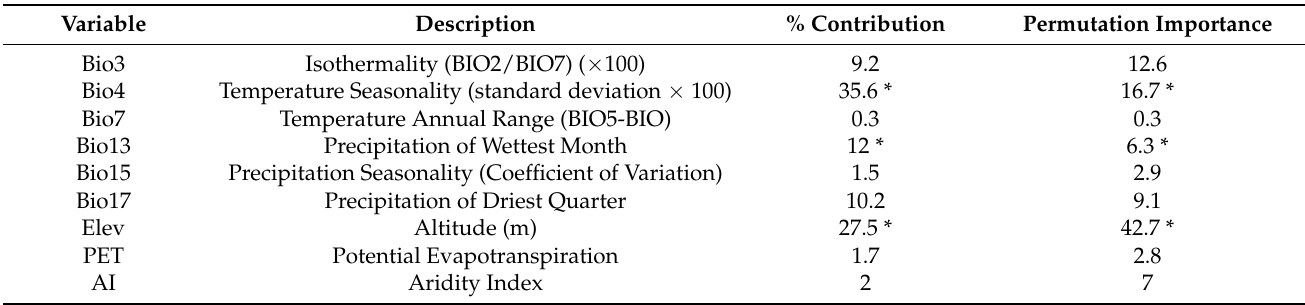
Table 1. Environmental variables and their percent contributions and permutation importance used in building the final MaxEnt models for Garuga forrestii .